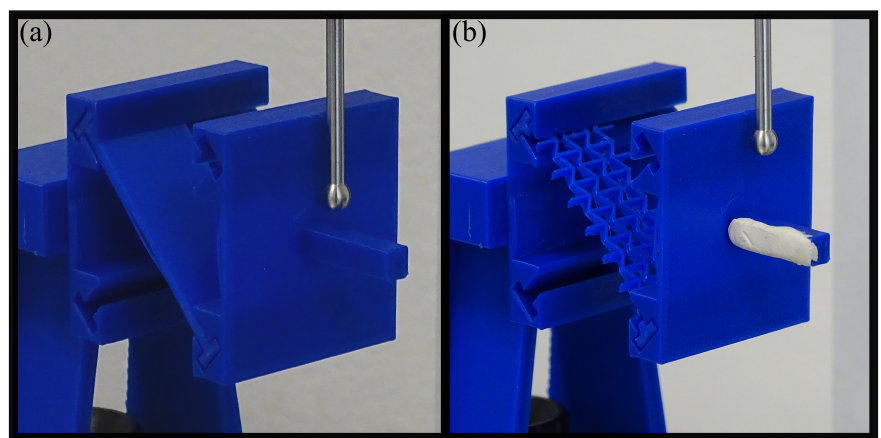
Figure 10. Compliant cross-axis joint tests with different flexure hinges. ( a ) Use of normal solid flexure hinges. ( b ) Use of re-entrant lattice-flexure hinges with a 3.5 mm unit cell and 0°